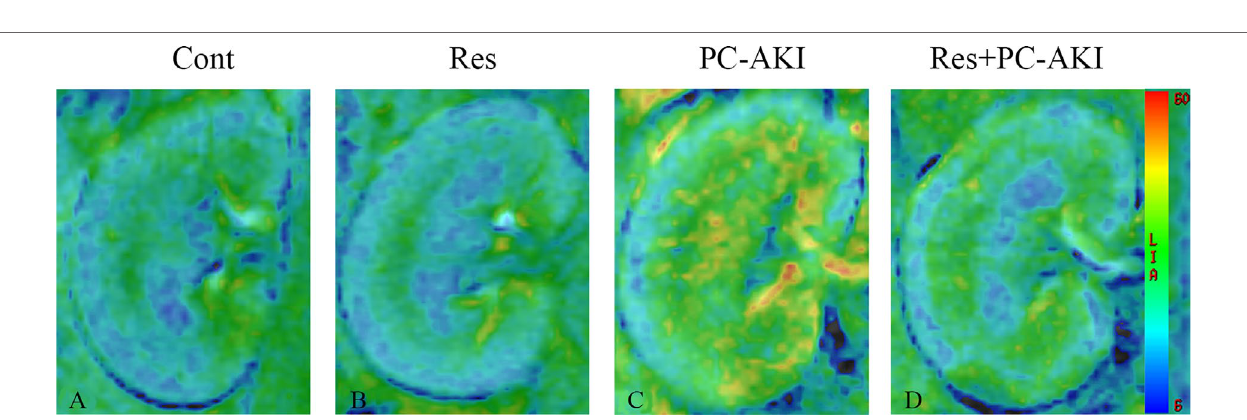
FIGURE 3 | Parametric images obtained from the BOLD model for rabbits with different treatments. The window and level settings for each map were kept the same. Compared to the control group, the brighter R2* maps in the PC–AKI group indicated increased hypoxia after iohexol injection. In the Res+PC–AKI group, the R2* values were significantly lower compared to the PC–AKI group, indicating increased oxygenation when using resveratrol before iohexol. (A) Control group, (B) Res group, (C) PC–AKI group, (D) Res+PC–AKI group. Cont, control; Res, resveratrol; PC–AKI, post-contrast acute kidney injury; BOLD, blood oxygenation